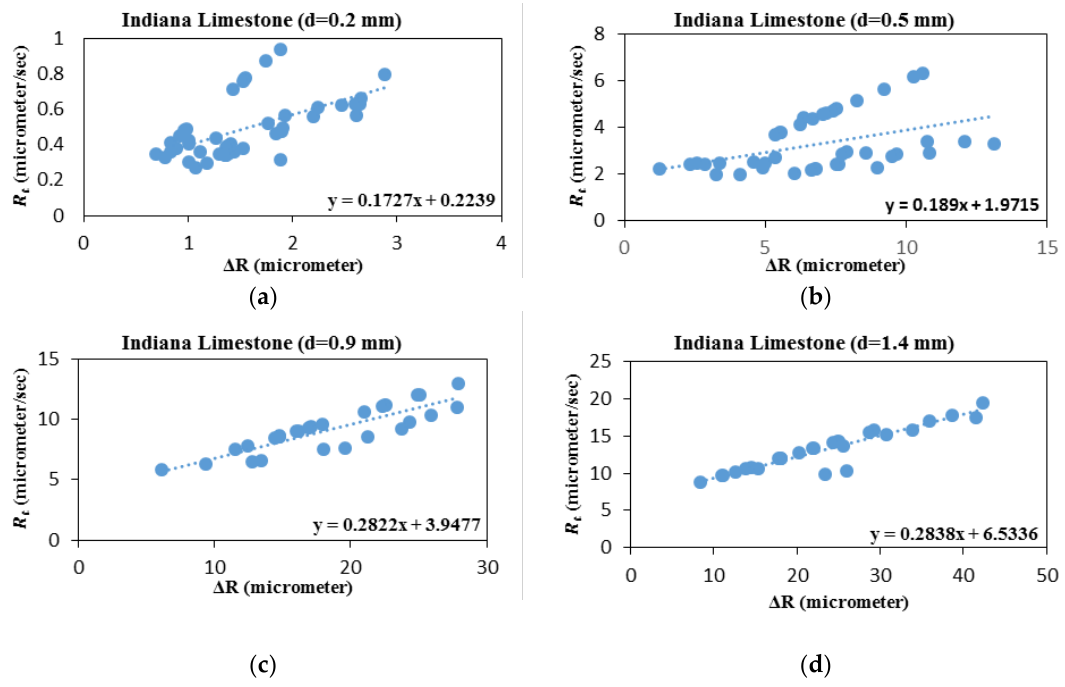
Figure 21. Evolution of R t and ∆ R values with increasing DOC: ( a ) d = 0.2 mm; ( b ) d = 0.5 mm; ( c ) d = 0.9 mm; ( d ) d = 1.4 mm.